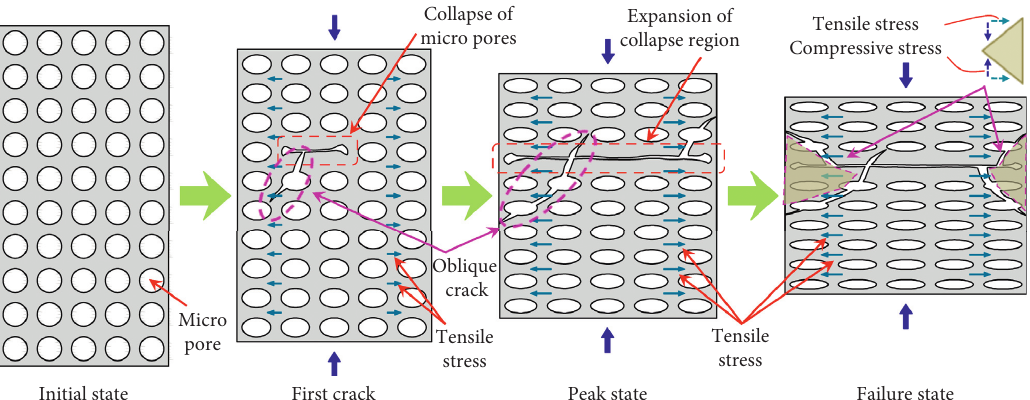
Figure 10: Damage evolution mechanism of specimens with mixed stress